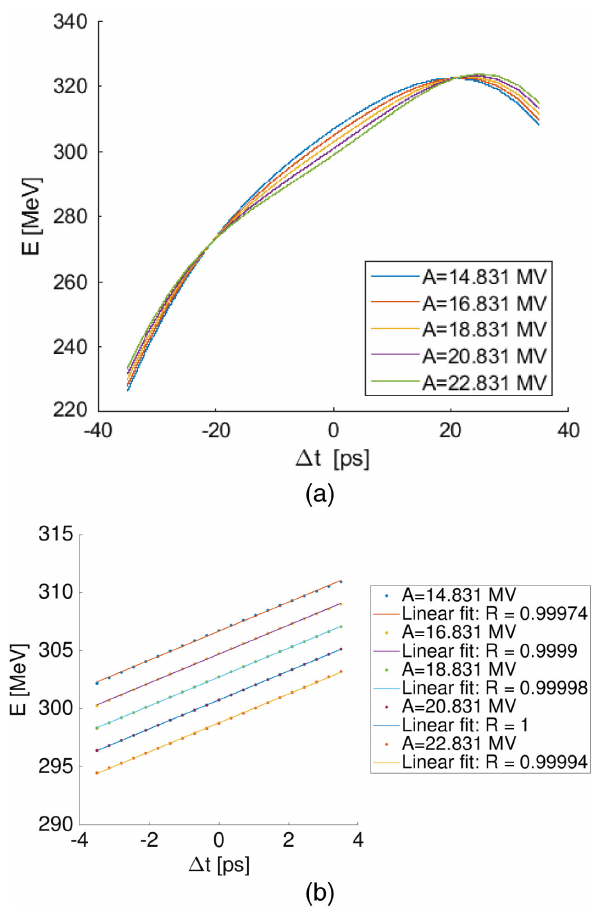
FIG. 2. Simulated energy gain as a function of arrival time jitter by varying the amplitude of the X-band in an extended (a) and a restricted (b) time window.